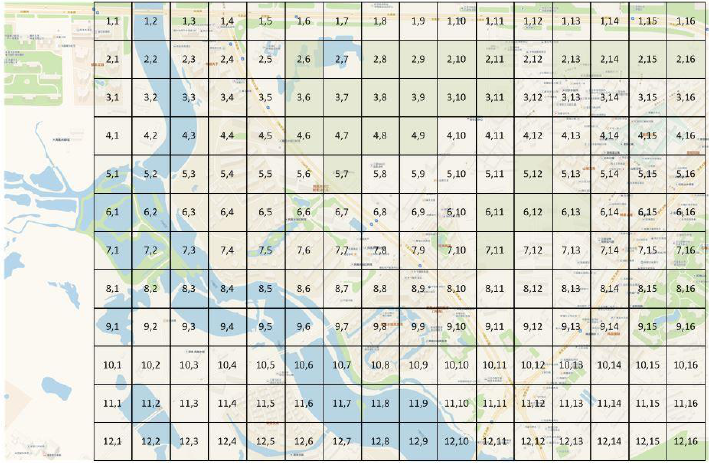
Figure 3. Grid division of the Hongshuwan experimental area.